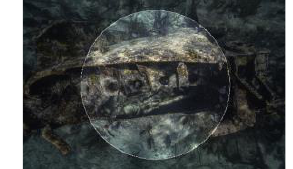
Figure 10. Circular mask adopted; the darker area will not be used during the calibration of the sensor and the feature detection (key-points) and matching (tie-points) steps.